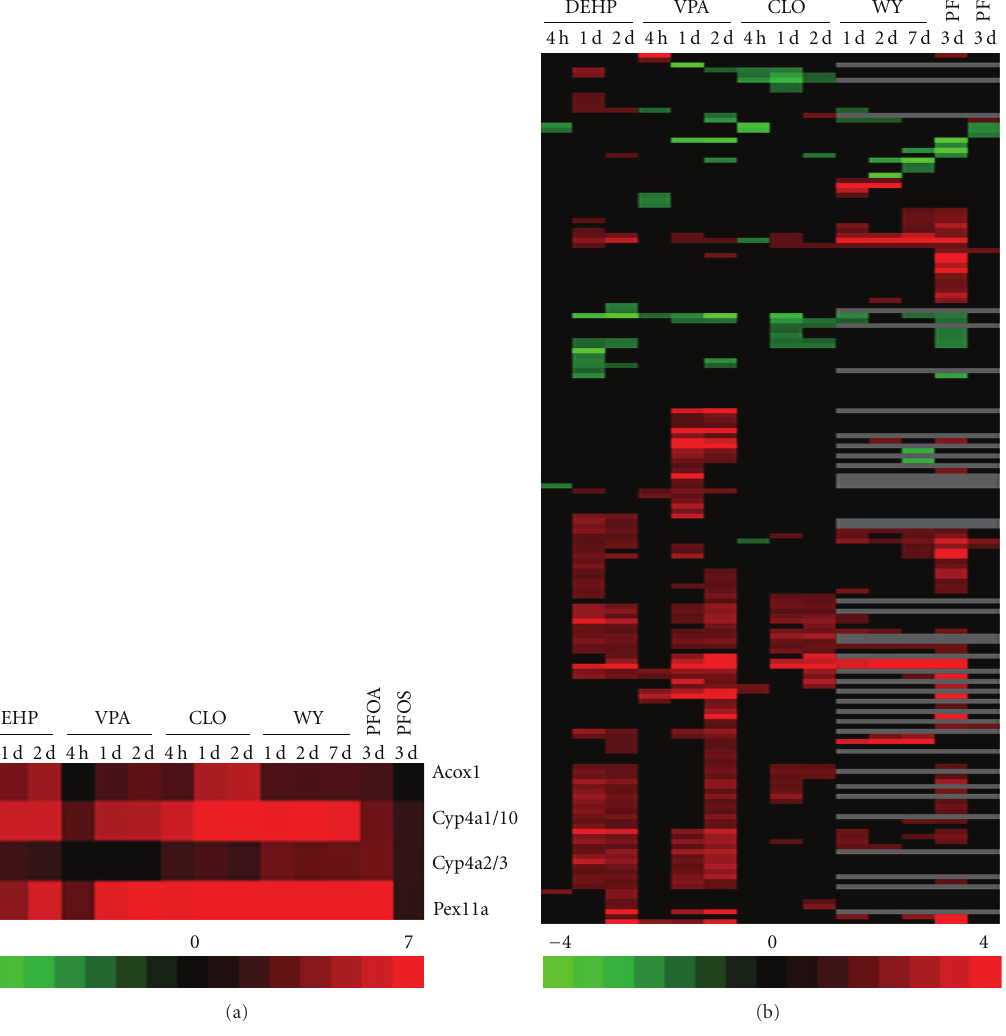
Figure 1: Altered expression of proteome maintenance genes by diverse PPC in rat liver. Male rats were treated with DEHP, VPA, CLO, WY, PFOA, or PFOS for the indicated times. Hepatic mRNA transcripts were assessed using A ff ymetrix arrays. Genes involved in PM including protein chaperones were identified asdescribed in Section 2. (a)Positive control genes. (b) Expressionof all PMgenes altered by at least oneof the treatments. Genes were clustered using one-dimensional hierarchical clustering. All genes are found in the Supplementary Material. Red: up-regulation; green: down-regulation; black: no change; grey: no data. The intensity scales indicates fold-change due to chemical exposure relative to controls. Abbreviations: WY: WY-14,643; DEHP: di-(2-ethylhexyl)phthalate; PFOA: perfluorooctanoic acid; VPA: valproic acid; CLO: clofibrate; PFOS: perfluorooctane